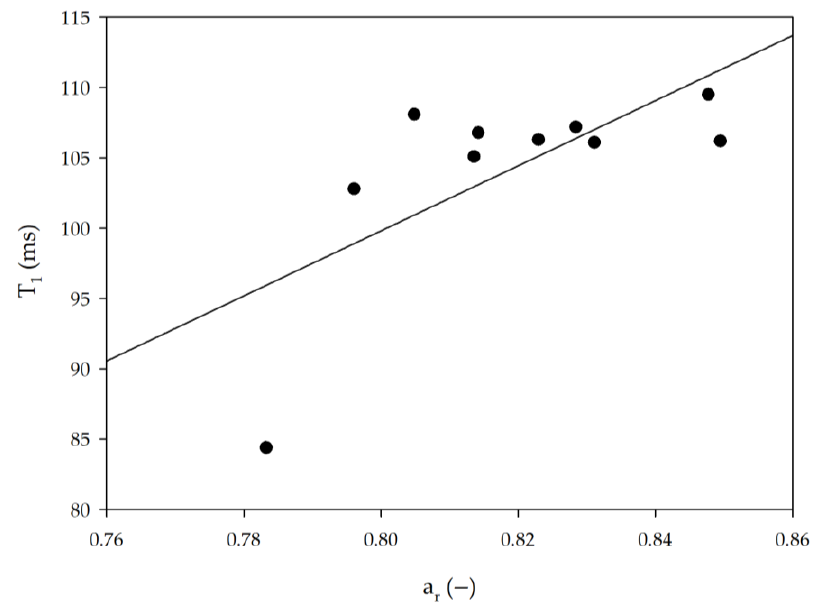
Figure 2. The dependence between rate of equilibrium value of water activity (a r ) and spin-lattice relaxation times ( T 1 ) in analyzed crumb samples.